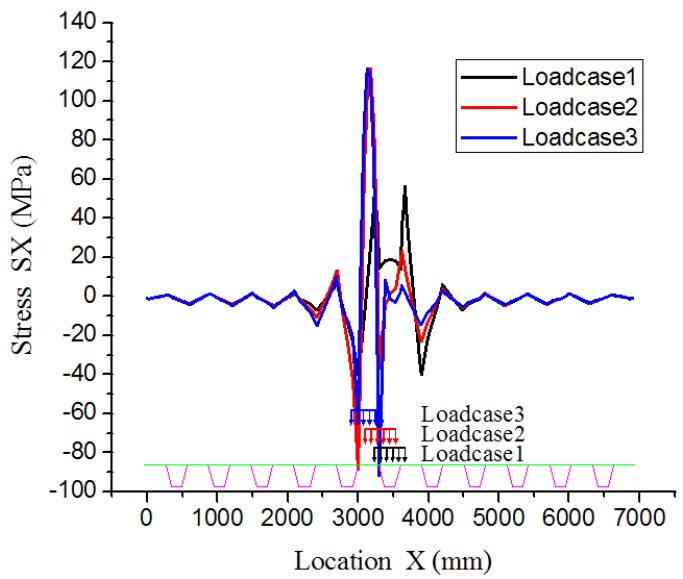
Figure 4: Stresses at the center deck plate of the middle span (Abruzzese et al., 2008)